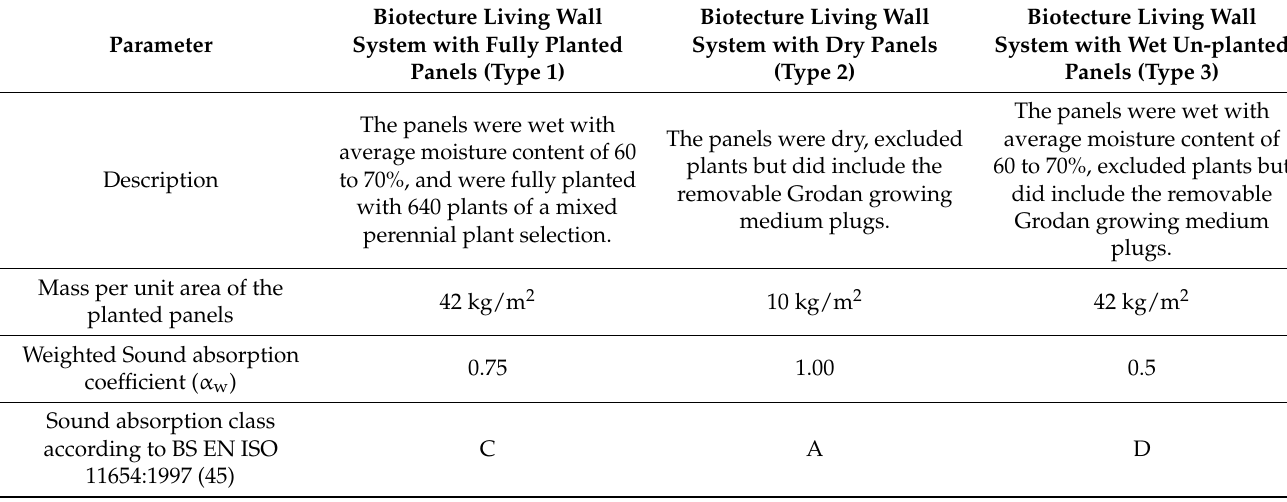
Table 2. The comparative characteristics of Biotecture’s green wall